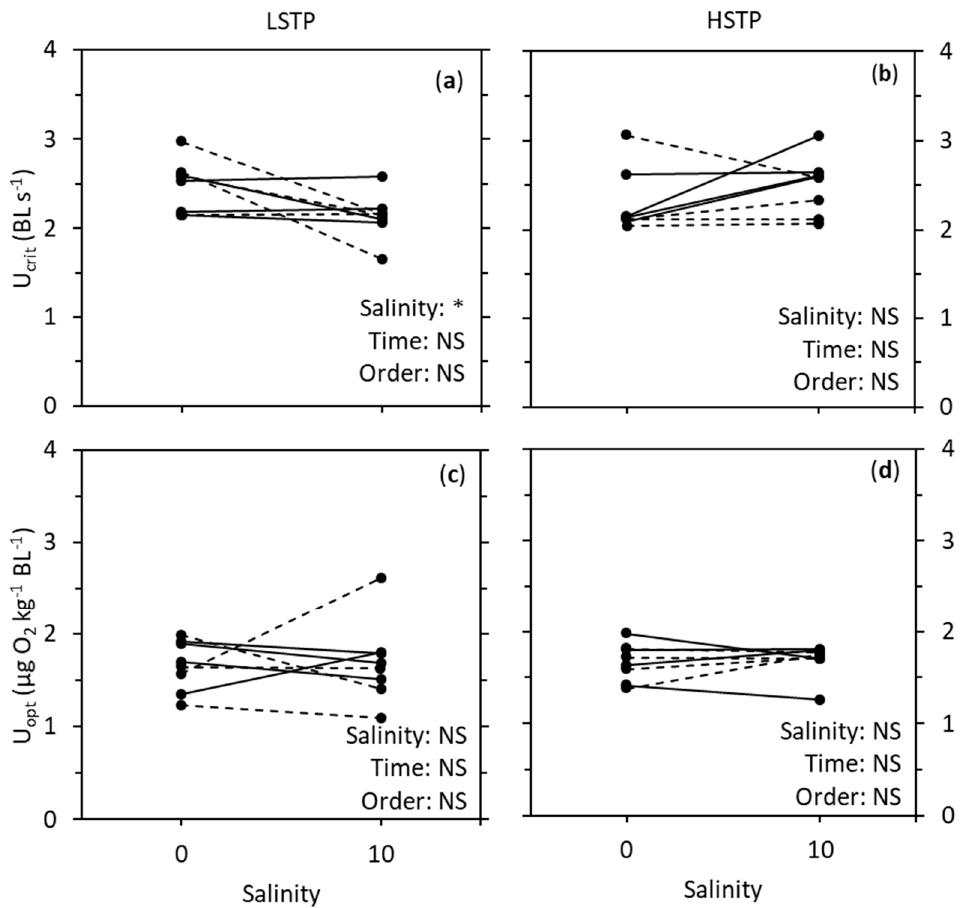
Figure 1. Critical swimming speed (U crit ; ( a , b )) and optimal swimming speed (U opt ; ( c , d )) of European perch ( Perca fluviatilis ) from a low salinity tolerance population (LSTP; ( a , c )) and a high salinity tolerance population (HSTP; ( b , d )). “BL” is body lengths. U crit and U opt was determined at salinities of 0 and 10. The total sample size was 16, with 8 individuals being used repeatedly at both salinities. Half the individuals experienced the salinity treatments in the order 0–10 (full lines), the other half in the order 10–0 (dashed lines). The results were analyzed with a general linear model which included salinity, time (first salinity treatment vs. second salinity treatment, one month apart), and the order of which the experiments were repeated on the fish. “*” and “NS” represent p < 0.05 and not significant,